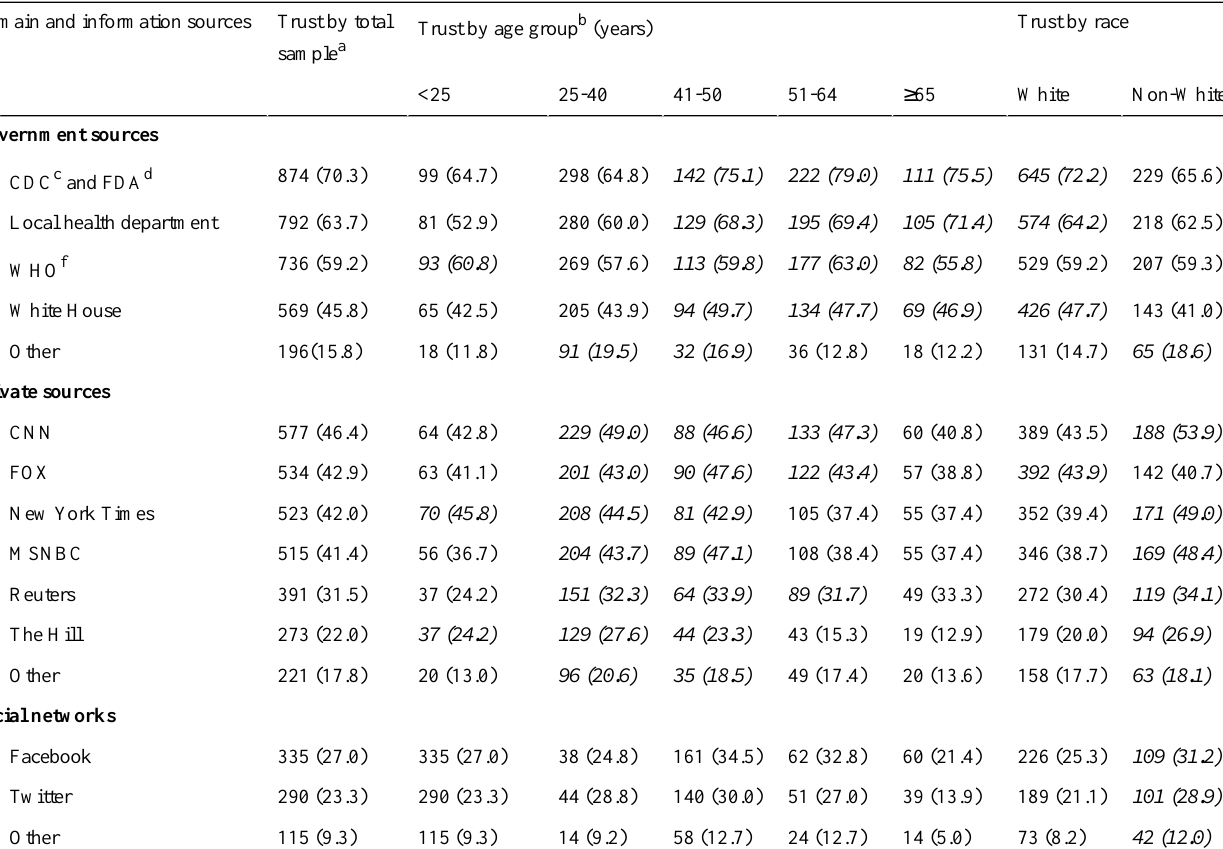
Table 2. Numbers of participants who trust each information source (N=1243), n (%). Trust was defined as binary (trust vs no trust) regarding providing accurate information about